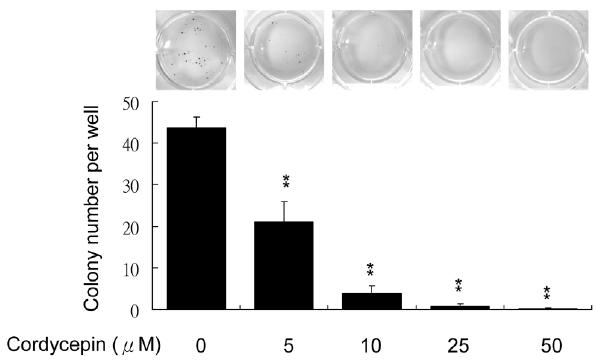
Figure 3. Cordycepin suppresses colony formation of leukemia cells. U937 cells were treated with indicated concentrations (5 to 50 m M) of cordycepin and colony formation was determined by a soft agar assay. These data are from three independent experiments. Each